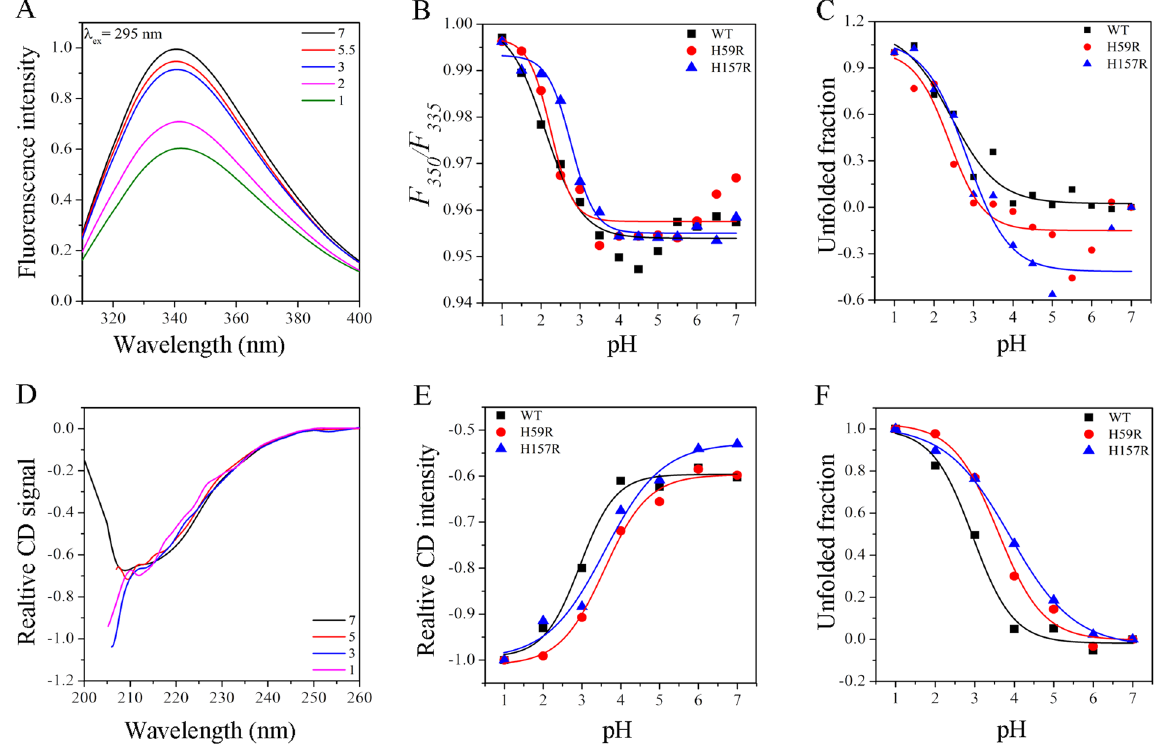
Figure 3. The acidic unfolding curves of Pin1-WT, H59R and H157R. ( A ) The representative fluorescence spectra of Pin1-WT. ( B ) The structural changes in the F 350 /F 335 ratio for the spectra of Pin1-WT, H59R and H157R. ( C ) The acidic unfolding curves of Pin1-WT, H59R and H157R on the basis of fluorescence spectra with λ ex = 295 nm. ( D ) The representative far-UV CD spectra of Pin1-WT. ( E ) The relative intensity of far-UV CD spectra of Pin1-WT, H59R and H157R at 208 nm. ( F ) The acidic unfolding curves of Pin1-WT, H59R and H157R on the basis of far-UV CD spectra.